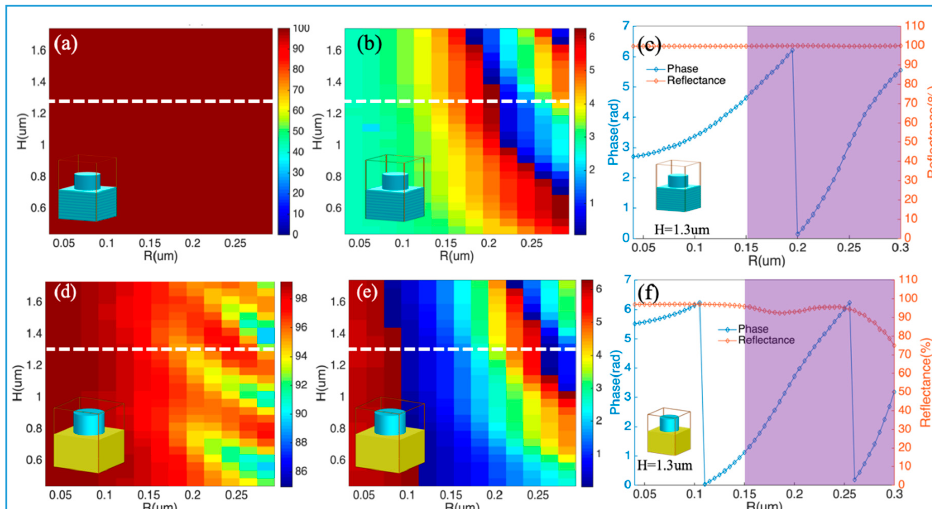
Figure 3. Geometrical dependence of reflection on parameters R and H : ( a ) reflectance and ( b ) phase di ff erence for light reflected by a DBR reflector with HfO 2 nanopillars atop; ( c ) reflectance and phase di ff erence with constant height H = 1.3 µ m, marked by a white dotted line in ( a ) and ( b ); ( d ) reflectance and ( e ) phase di ff erence for light reflected by an Au film with HfO 2 nanopillars atop. ( f ) reflectance and phase di ff erence with Au film as a bottom mirror and constant height H = 1.3 µ m, marked by a white dotted line in ( d ) and ( e ). The purple shaded areas of ( c ) and ( f ) are in the R range from 0.15 µ m to 0.3 µ m, in which the phase di ff erence covers the 0–2 π range with high reflectance. The inserted images show the unit cells with DBR or Au Film as a bottom